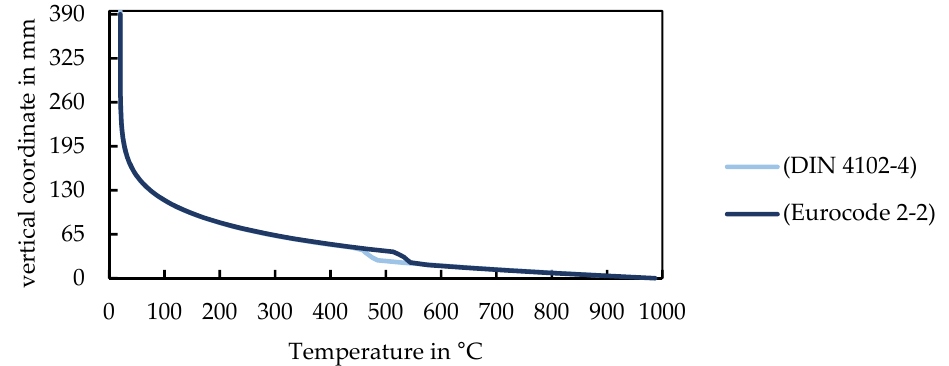
Figure 10. Temperature curve of the solid slab after 90 min fire exposure with dimensions based on [5,6].